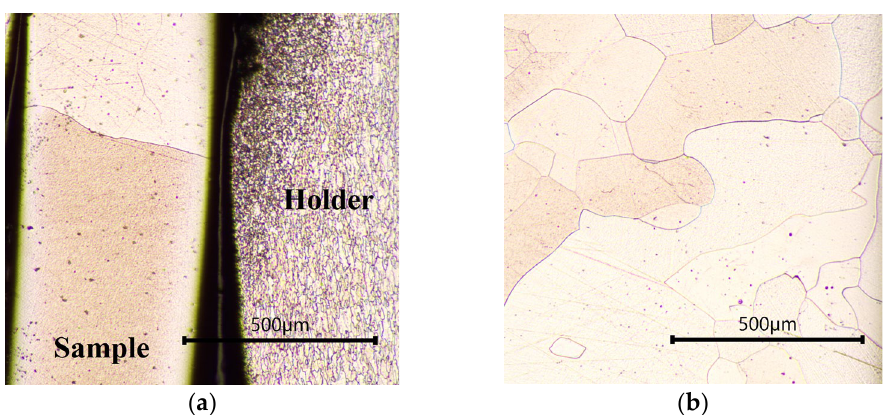
Figure 5. Optical micrograph showing the microstructure of the thermally treated material: direction of rolling ( a ) perpendicular; ( b ) in parallel with the viewing